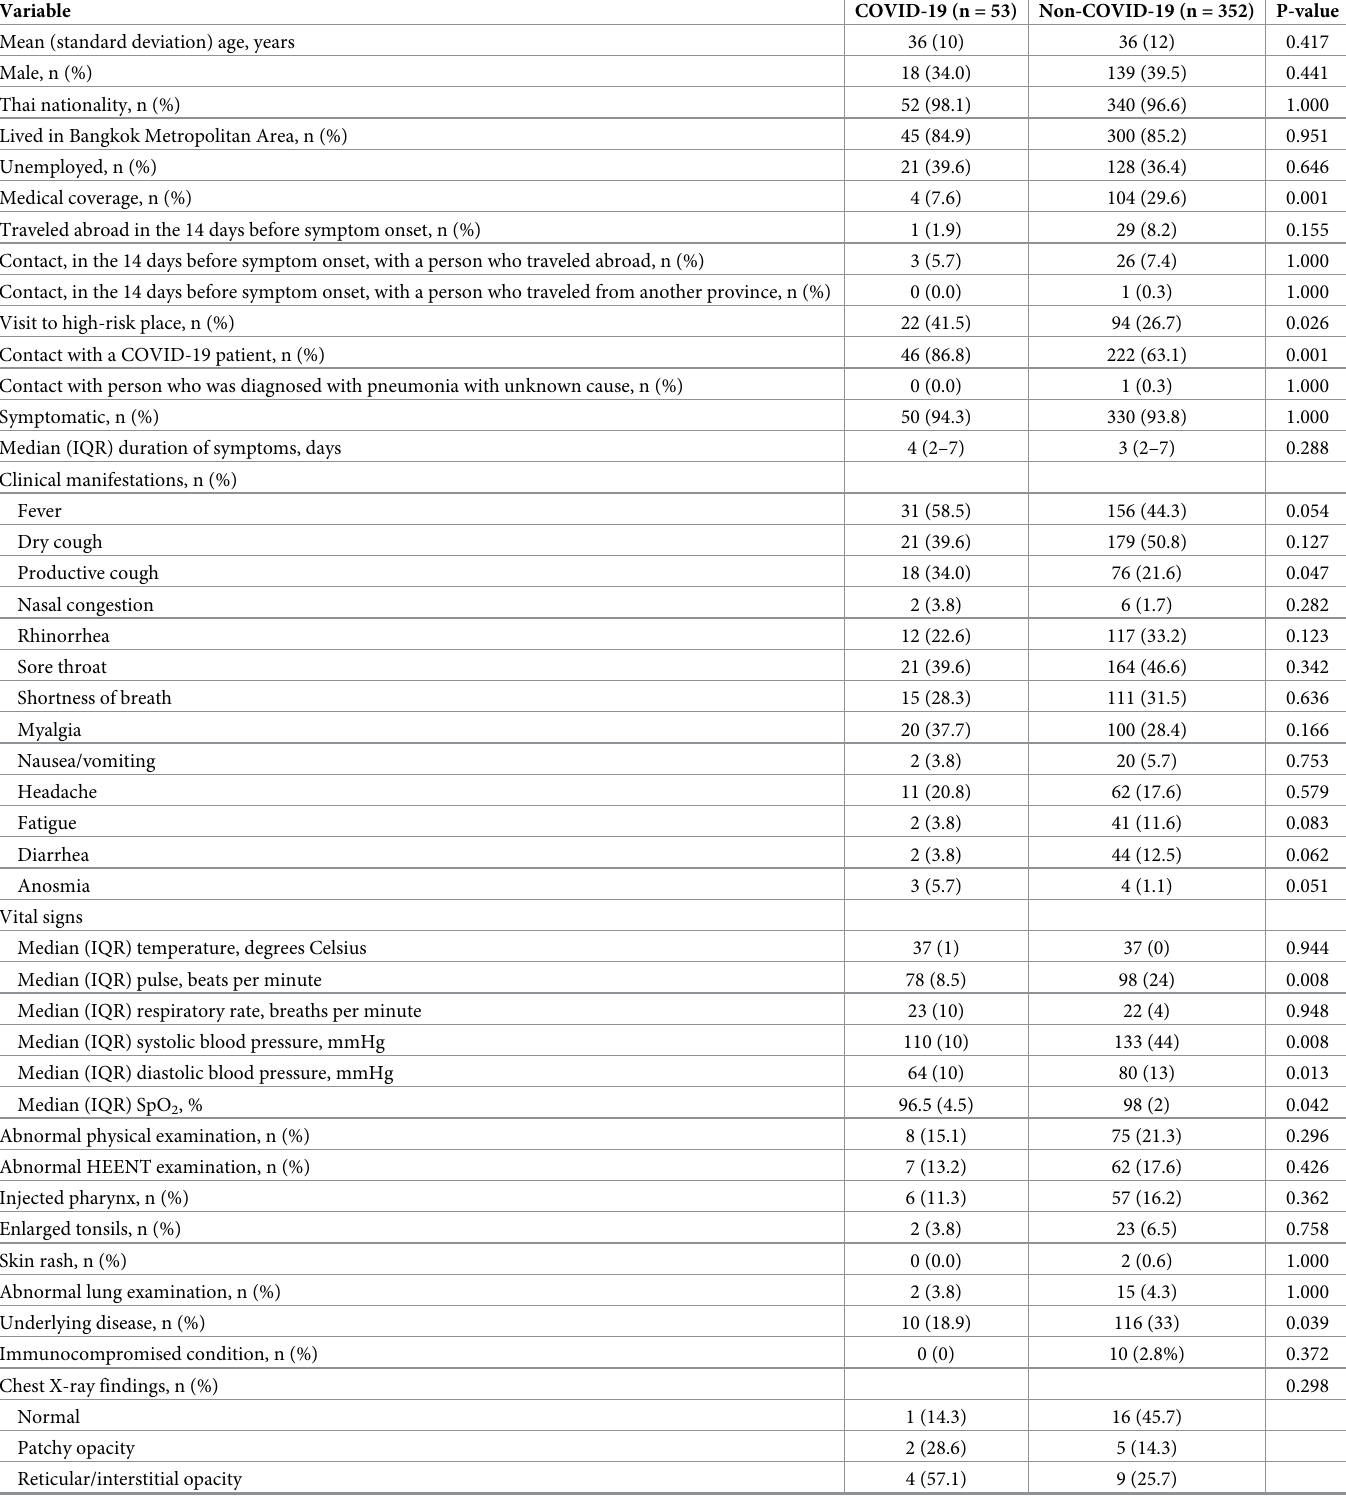
Table 2. Baseline characteristics of patients under investigation with and without